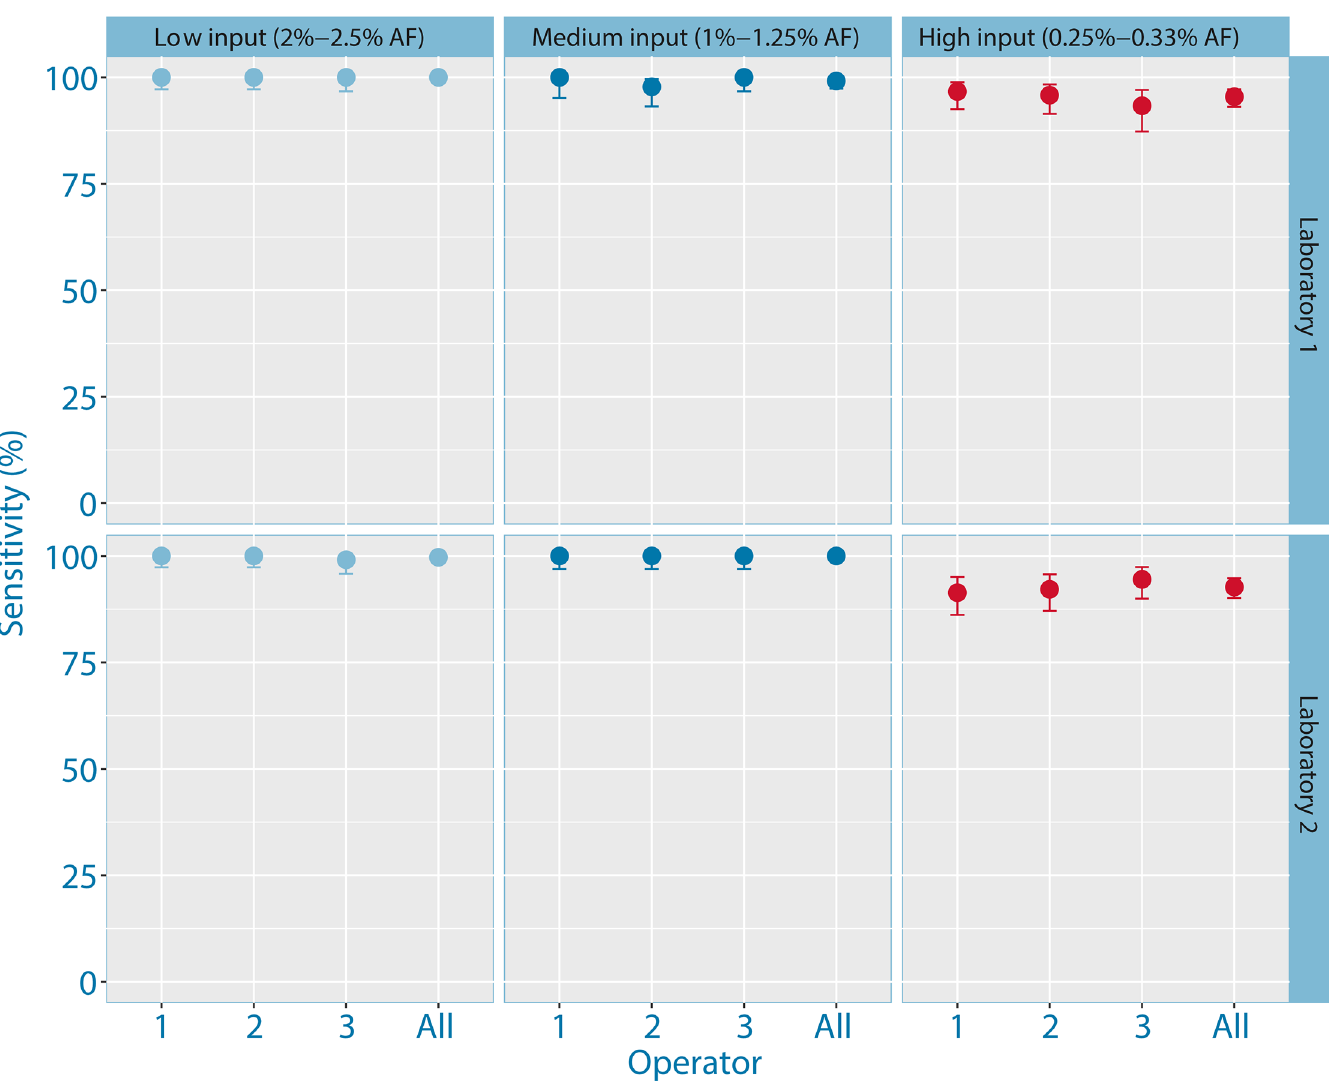
Fig 2. Plot showing sensitivity and inter-operator variability of eTAm-Seq technology using low, medium and high input DNA. Experiments were performed in two laboratories (Laboratory 1 –upper; Laboratory 2 –lower) by different operators, performed on separate days and different NGS runs.